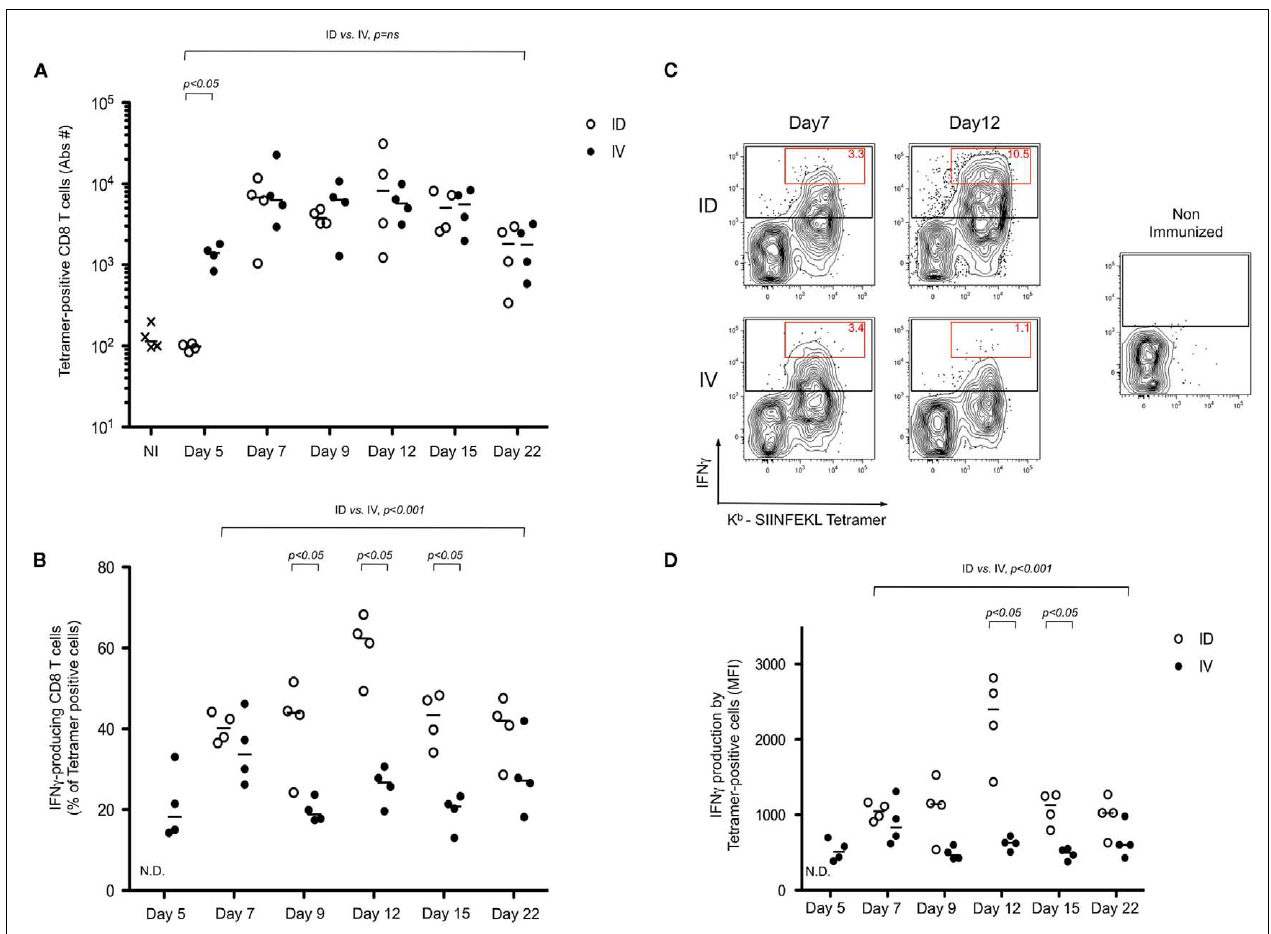
FIGURE 3 | Intradermal immunization results in a more robust differentiation of effector CD8 + T cells. (A–D) Mice were immunized i.d. or i.v. with 5 × 10 5 K bm1 mOva splenocytes.Three hours prior to the defined time point, mice were re-stimulated in vivo by injecting 5 μ g